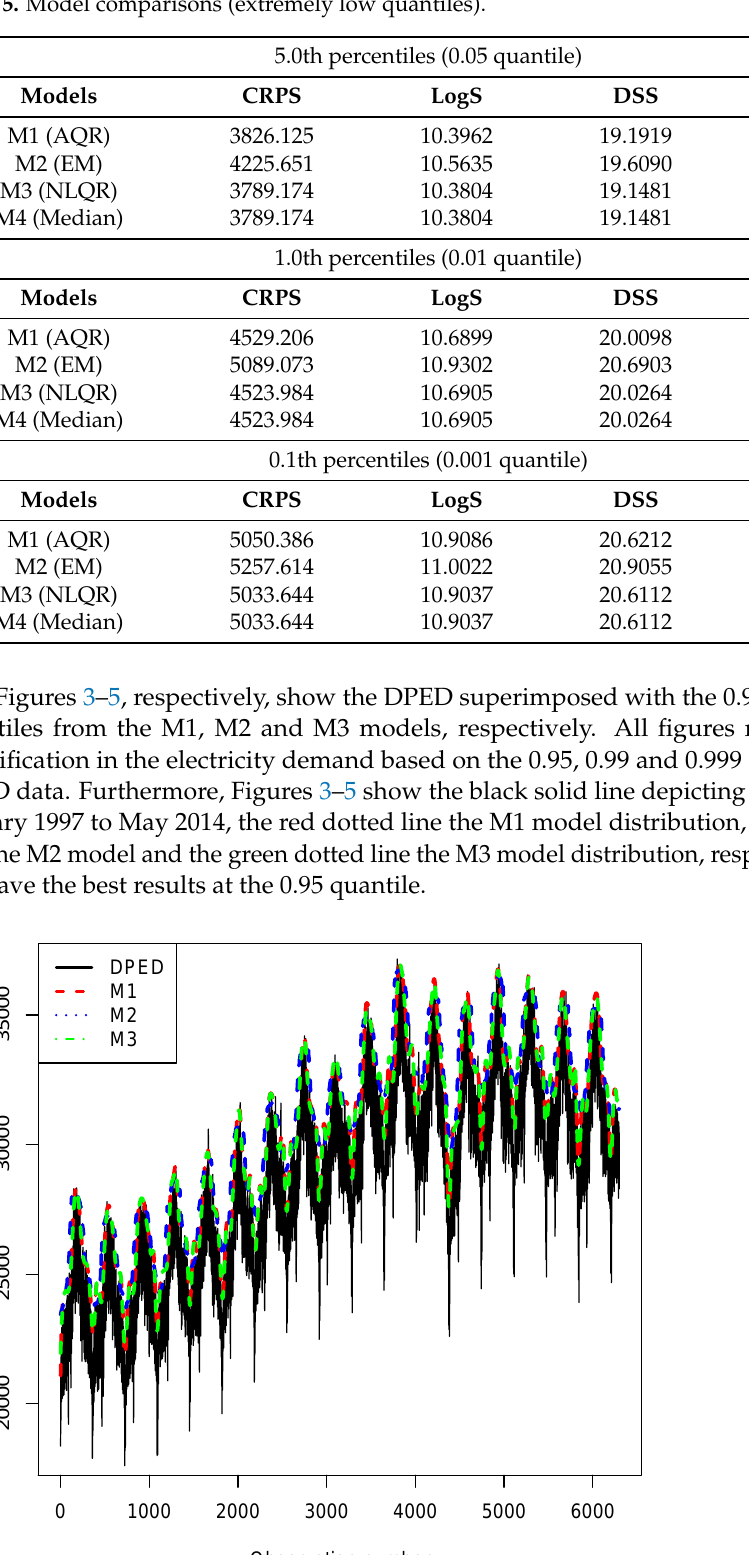
Table 5. Model comparisons (extremely low quantiles).